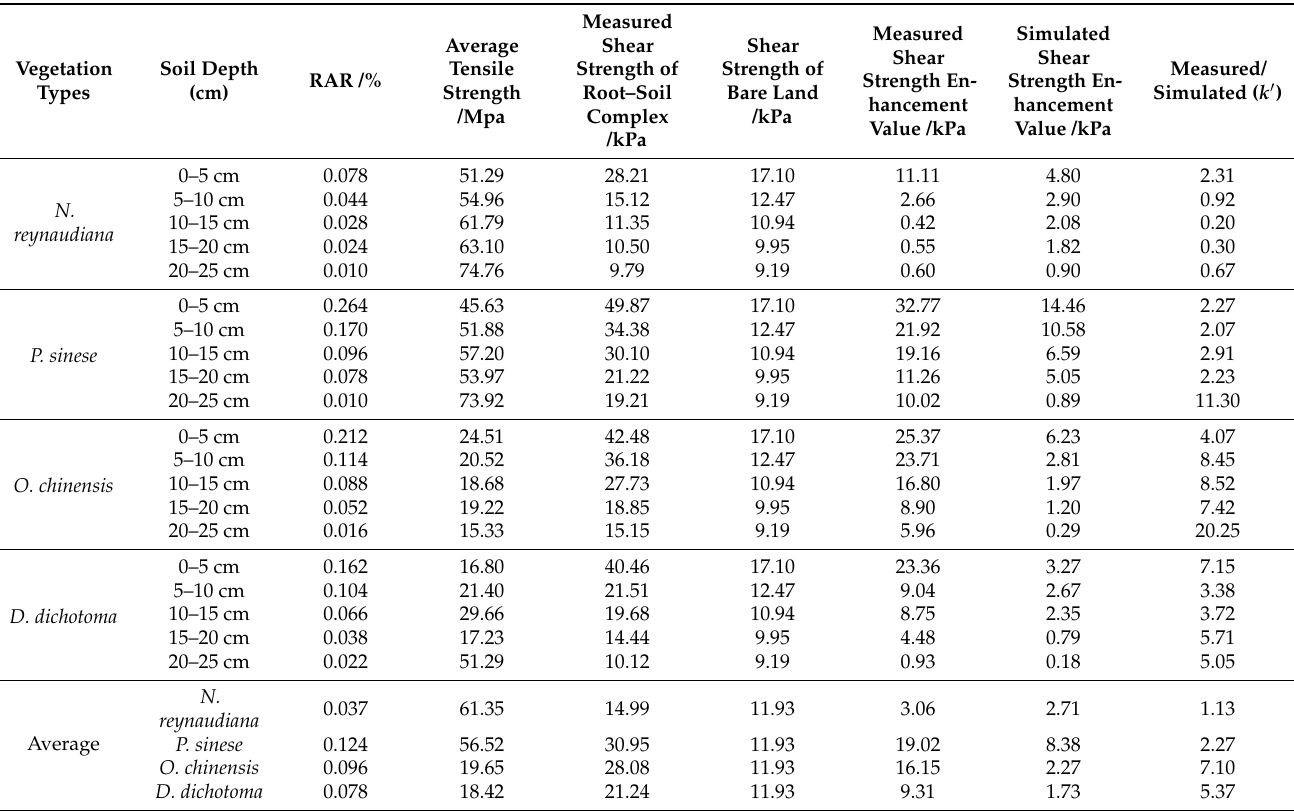
Table 11. Simulation and modification results of WWM model under different vegetation